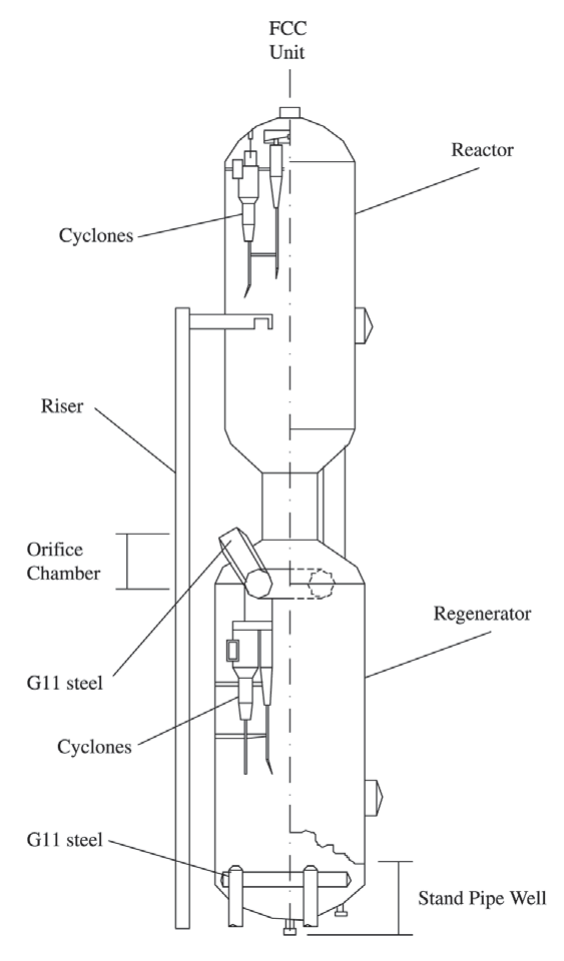
Figure 1. Schematic drawing of the FCC unit, indicating the local inside the regenerator where the G11 steel samples were fixed.